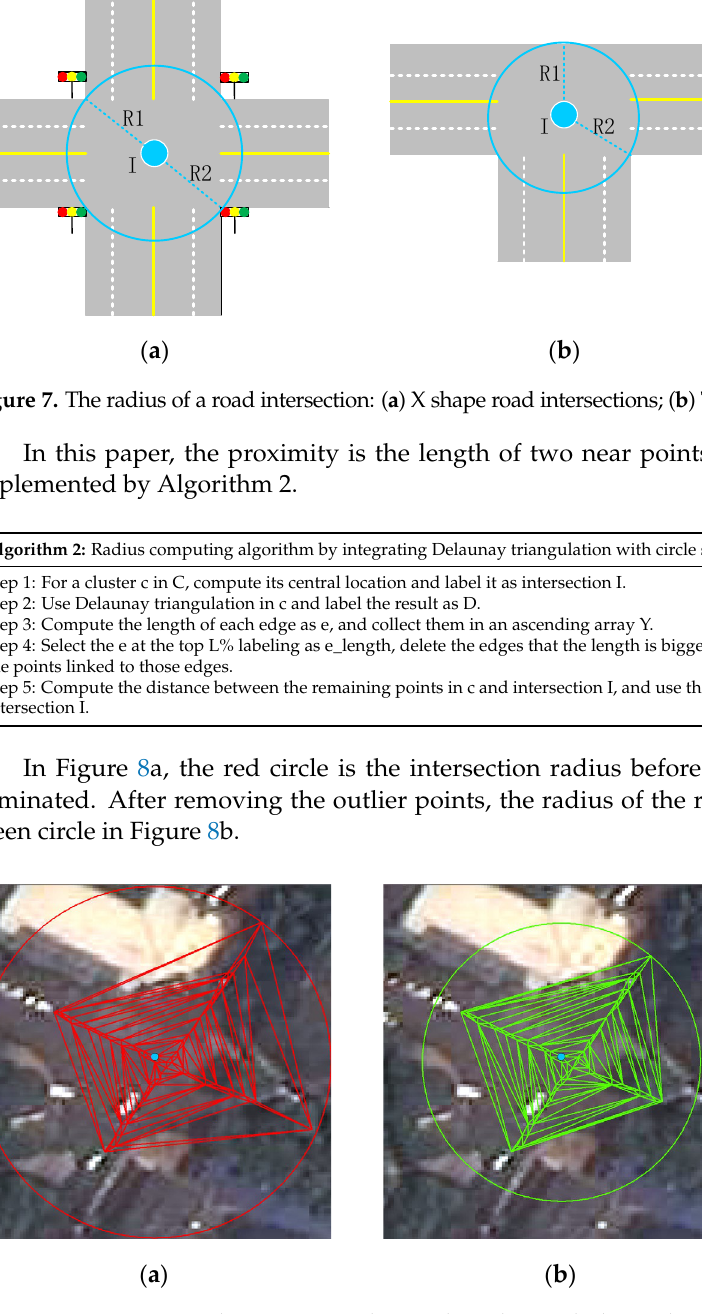
8 of 15 Algorithm 1: Center coordinate detection algorithm via combining classification model and clustering algorithm Step 1: Initialize all the points as unvisited. Step 2: If all the points are visited, output cluster set C. Otherwise, randomly pick a point p from unvisited points and label it as visited. Step 3: p_neighbor is p’s neighbor points. Calculate p’s neighbor number p_num. Step 4: If p_num is larger than the threshold N, build an array c and an array X. Col- lecting p into c and collecting p_neighbor into X. Otherwise, labeling p as noise. Step 5: If all the points in X are visited, go to Step 8. Otherwise, select an unvisited point in X and label it as visited. Step 6: Count the number x_num of x’s neighbor points. x_neighbor represents x’s neighbor points. Step 7: If x_num is bigger than N, collect x into c, collect x_neighbor into X, and go back to Step 5. The radius of a road intersection is calculated after center coordinate detection. We reckon the area of a road intersection as a circle, shown as the area I within the blue circle in Figure 7. Its radius is the average of R1 and R2. Both R1 and R2 are manually labeled according to remote sensing images for evaluation in Section 4.2. We propose to integrate the Delaunay triangulation algorithm with the circle shape for figuring out intersections’ radiuses. The circle shape is the same as the literature [2]. For a cluster, some points may